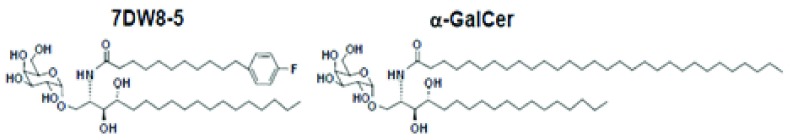
Structure of 7DW8-5 and α-galactosylceramide (α-GalCer).